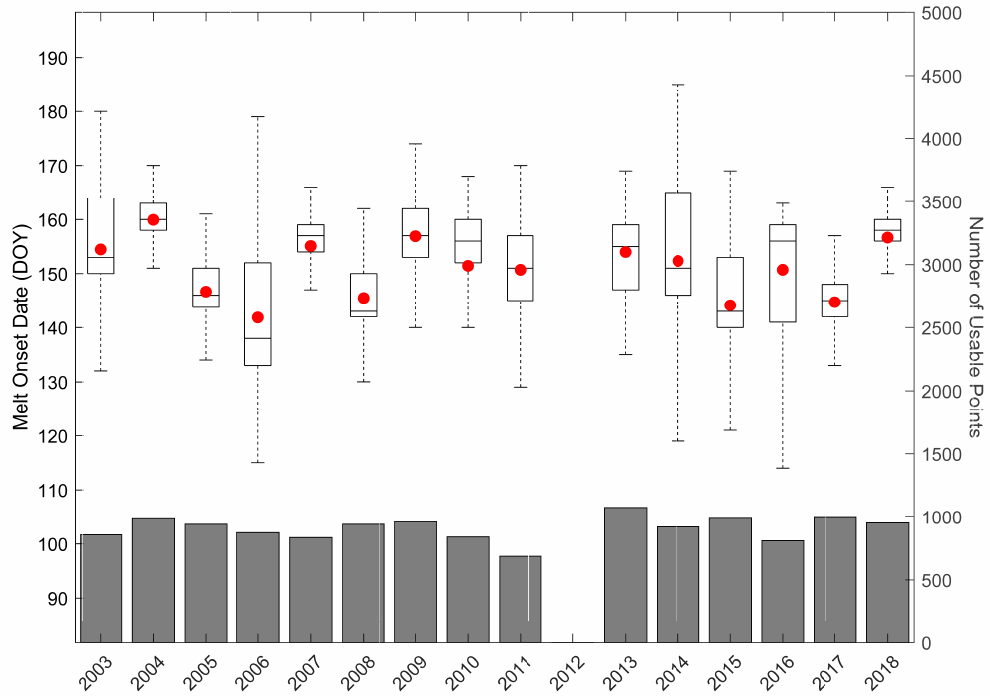
Figure 9. DTVM MO statistics from 2003 to 2018 at the 25 km resolution. Red dots indicate mean MO value for each year. Horizontal lines indicate the median and box edges indicate the 25 and 75 percentiles. Maximum and minimum values indicate the maximum and minimum values from each year not considered an outlier. Outliers are defined as points farther than three scaled median absolute deviations from the median. The bar chart at the base of the figure indicates the number of points used for each year to determine the